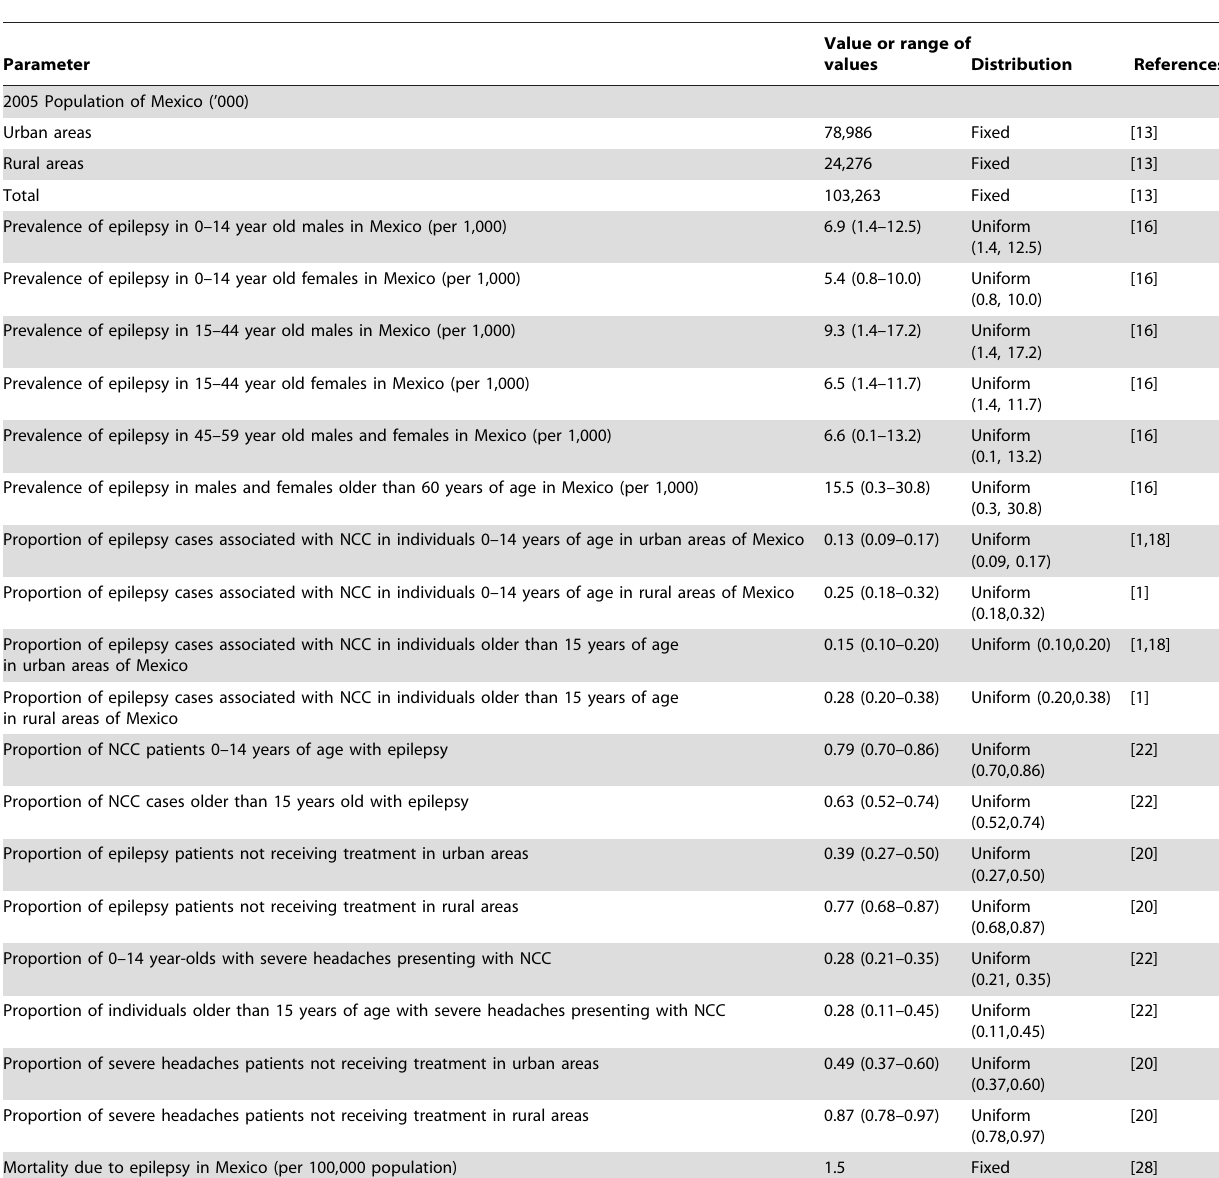
Table 1. Epidemiological parameters used to calculate DALYs for NCC-associated epilepsy and severe chronic headaches in